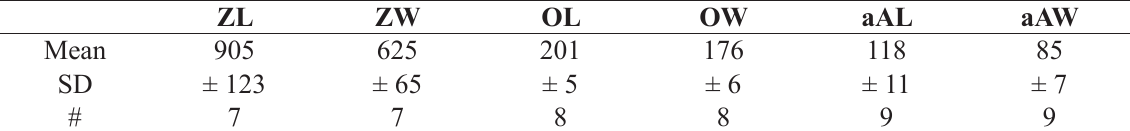
Table 15. Measurements of Calvetopora